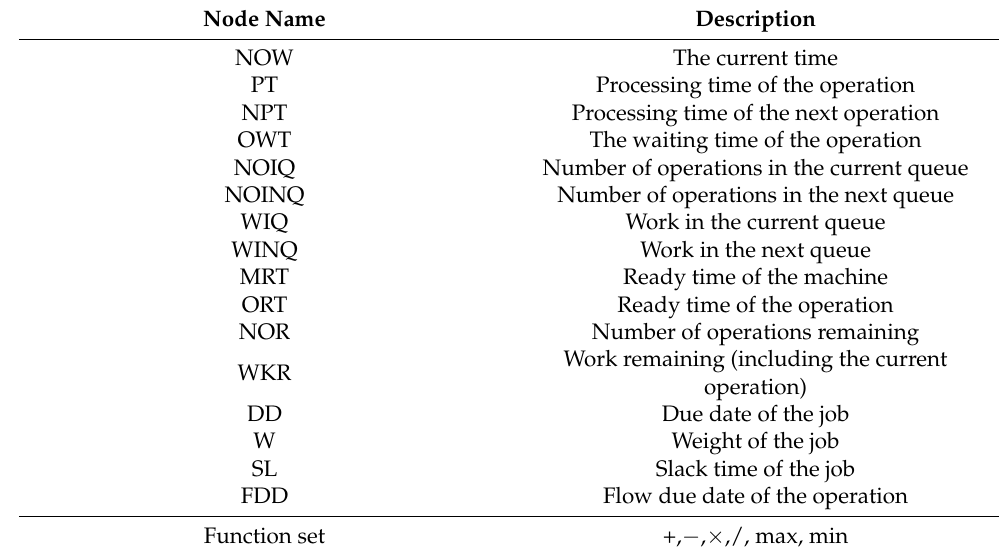
Table 2. The GP terminal and function sets.